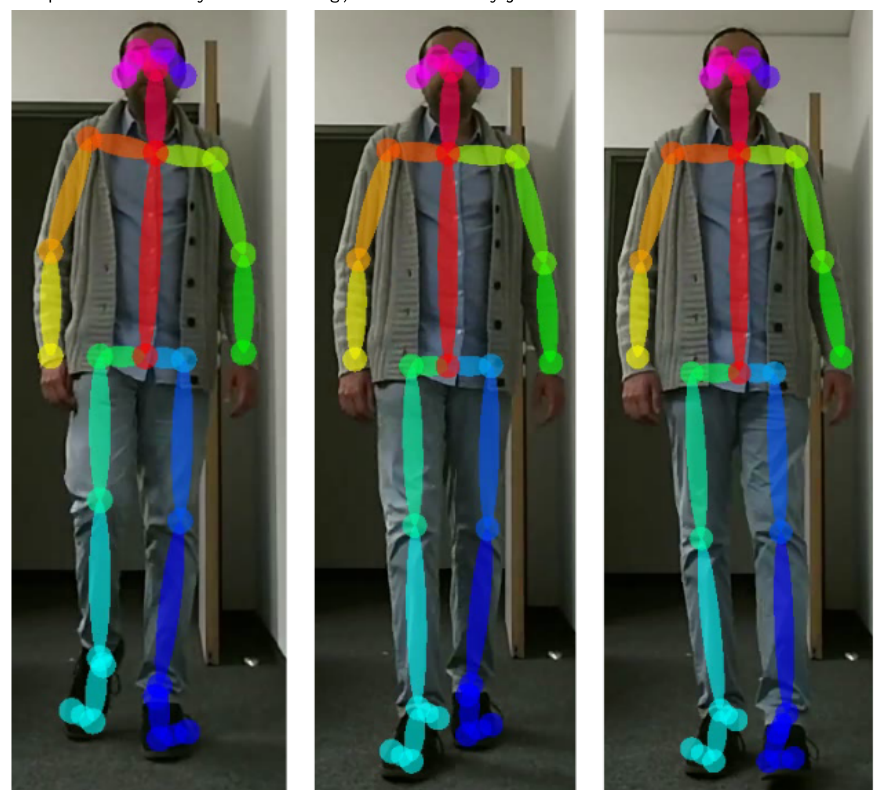
Figure 1. Two-dimensional pose estimation by skeleton fitting, based on 25 body joint